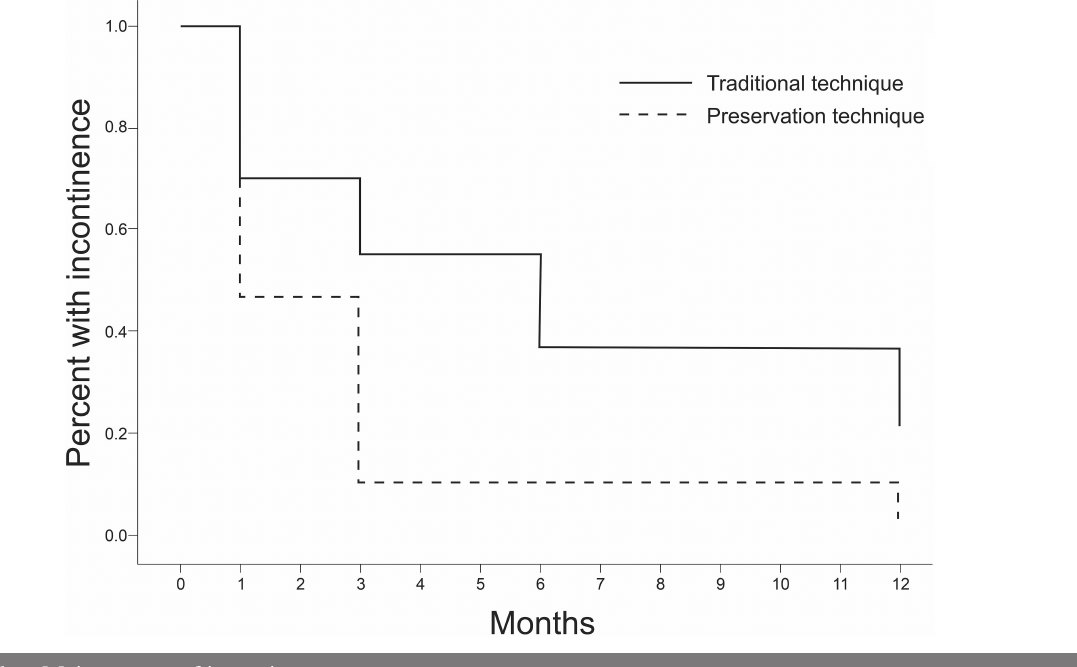
Figure 3. Kaplan–Meier curves of incontinence.